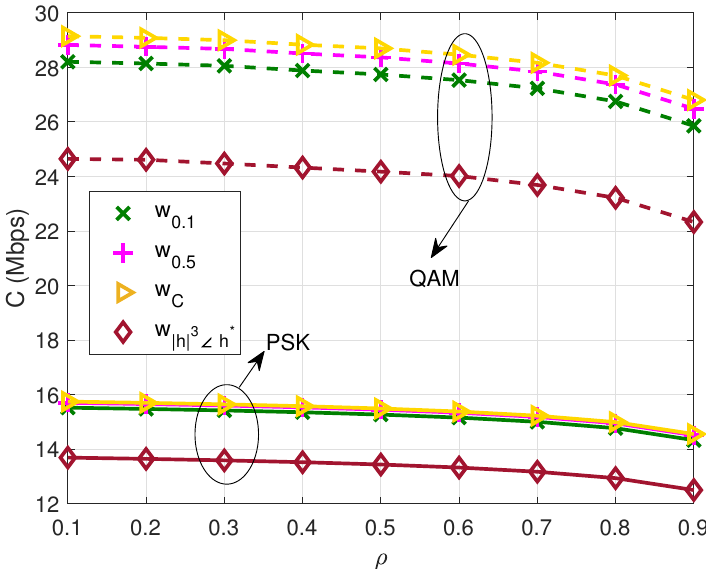
Figure 7. Capacity as a function of ρ for an 8-tone signal using multisine PSK and QAM modulation of 1 MHz BW, and adopting the proposed